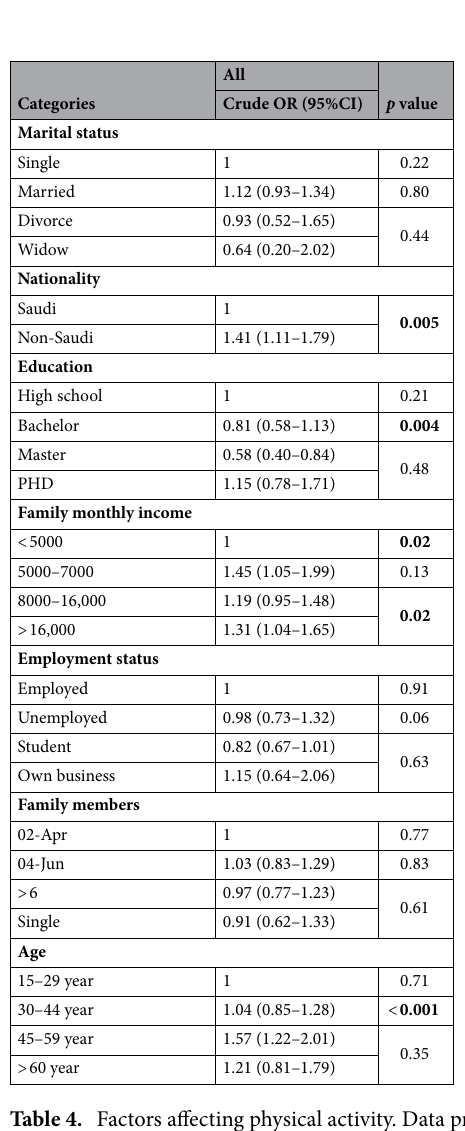
Table 4. Factors affecting physical activity. Data presented odd ratio (95% CI). p value < 0.05, 0.01 consider